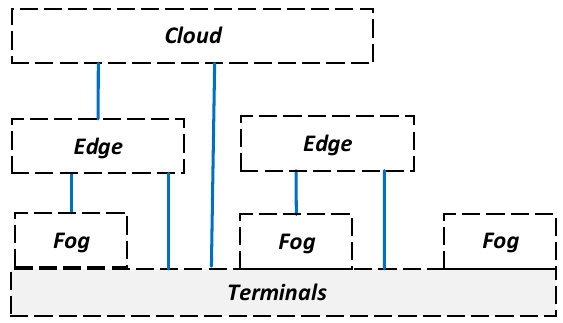
Figure 5. VMCS hierarchical orchestration